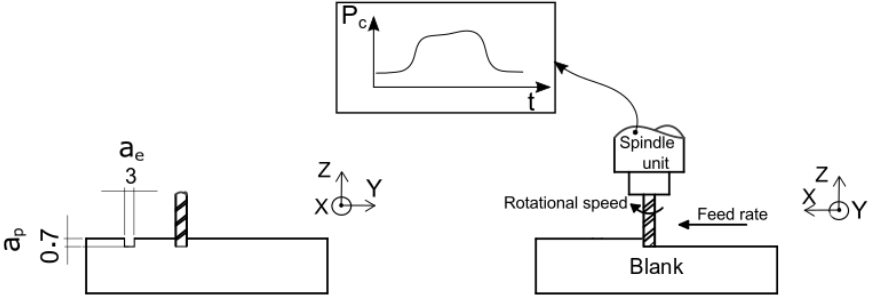
Figure 2. Schematic assembly of experimental setup (dimensions in Figure 2 . Schematic assembly of experimental setup (dimensions in mm) .